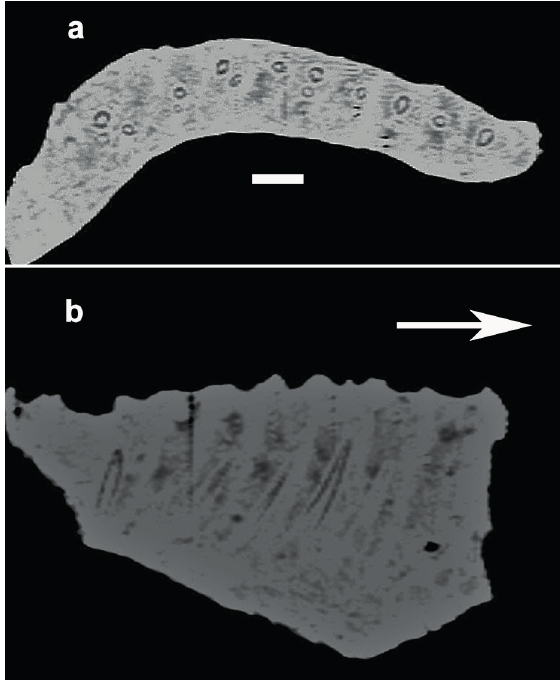
Figure 7 - Baalsaurus mansillai n.g.n.sp. Computed tomography-based digital visualization, a : slice in dorsal view, b : slice in lateral view. Arrows point to anterior. Scale bar: 1